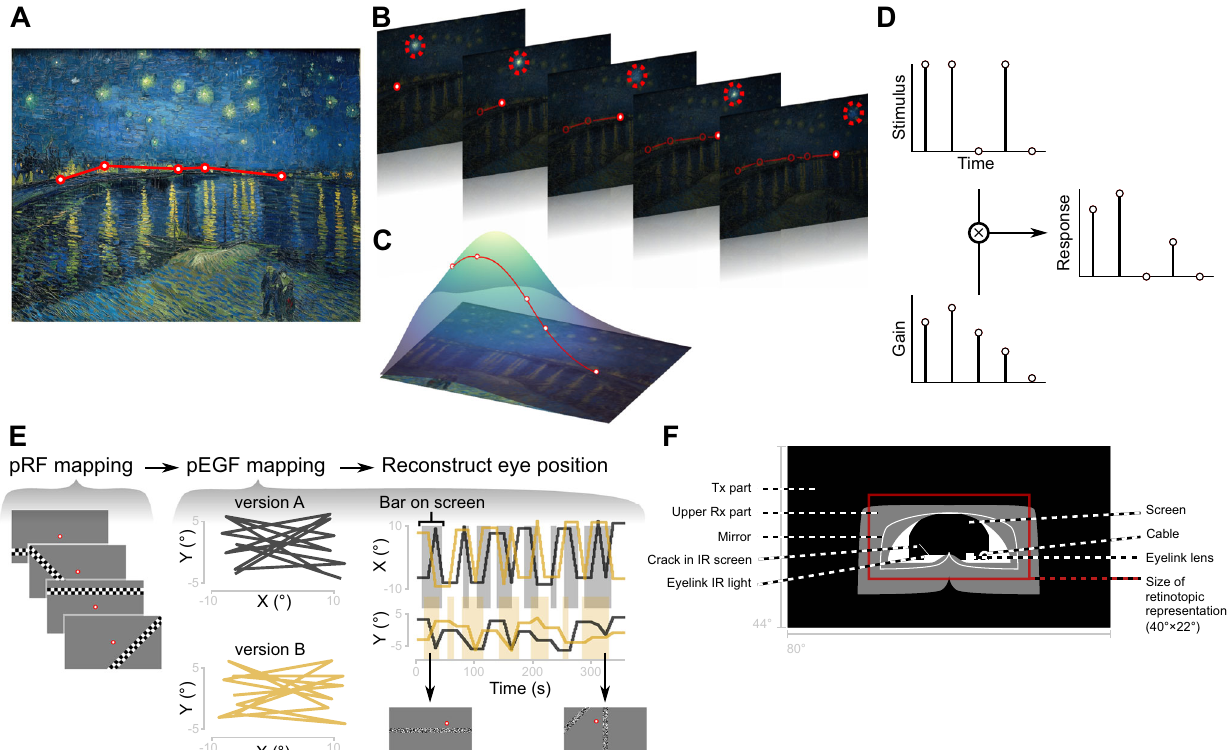
Fig. 1 | Conceptualization of eye-position dependent gain fi elds and methods. A Seriesof fi xations (red pointsand lines)made across “ Lanuitétoilée ” (vanGogh, 1888). B Example receptive fi eld totheupperrightof the fi xationpoint. C Example gain fi eld. D Giventheseriesof fi xationsin A andthereceptive fi eld locationin B ,a starfromthepaintingstimulatesthereceptive fi eldon fi xations1,2,and4.Thegain modulation, that follows from the gain fi eld in C , is strongest on fi xation 2. The multiplication of stimulus strength and eye-position dependent gain modulation determines the response strength. E In our fMRI experiment, we measured popu- lations of neurons contained within a single voxel. We fi rst mapped population receptive fi elds(pRF)usingastandardmovingbarparadigm.Next,weusedversion Aofanoveleye-movementtask(black)tomappopulationeye-positiondependent gain fi elds (pEGF): pEGF mapping. While the participants were performing eye movements, high-contrast fl ickering bars were presented at various times in